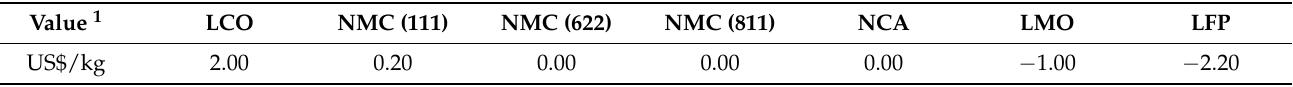
Table 3. Recycling values for different types of lithium-ion battery chemistries. Source: [35].